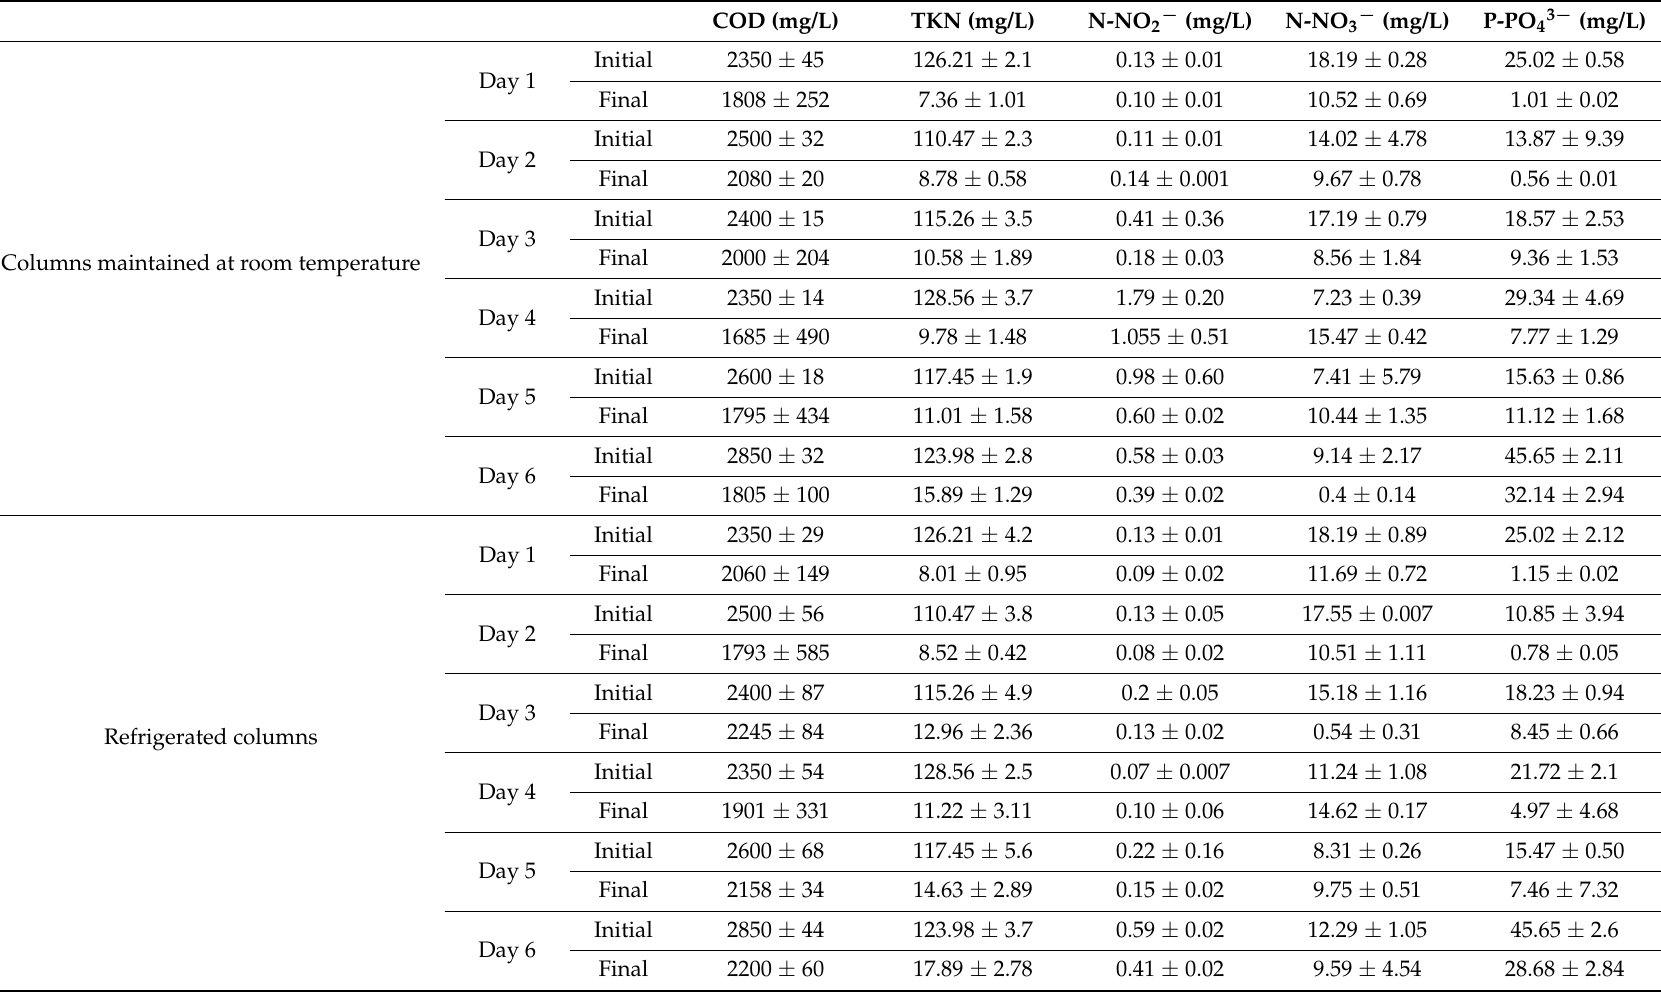
Table 7. Initial and final concentration of nitrogen and phosphorus in the columns, concerning the experiment for temperature